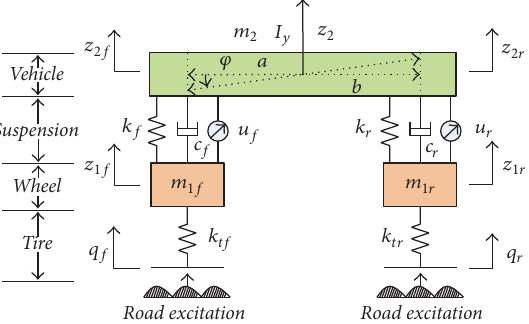
Figure 1: The active suspension dynamic model of half